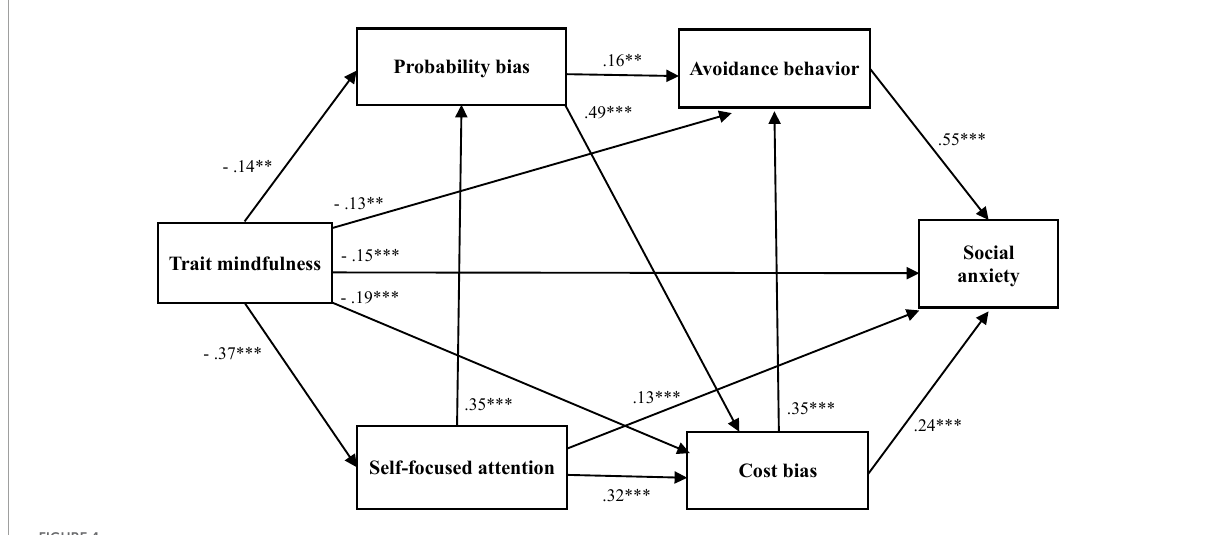
FIGURE4 Model fit and standardized parameter estimates for Model B. Chi-square values, χ 2 = 1.79, df = 2, p = 0.41; comparative fit index (CFI) = 1.000; Tucker–Lewis index (TLI) = 1.000; root mean square error of approximation (RMSEA) = 0.000, 90% CI = 0.000–0.100; and standardized root